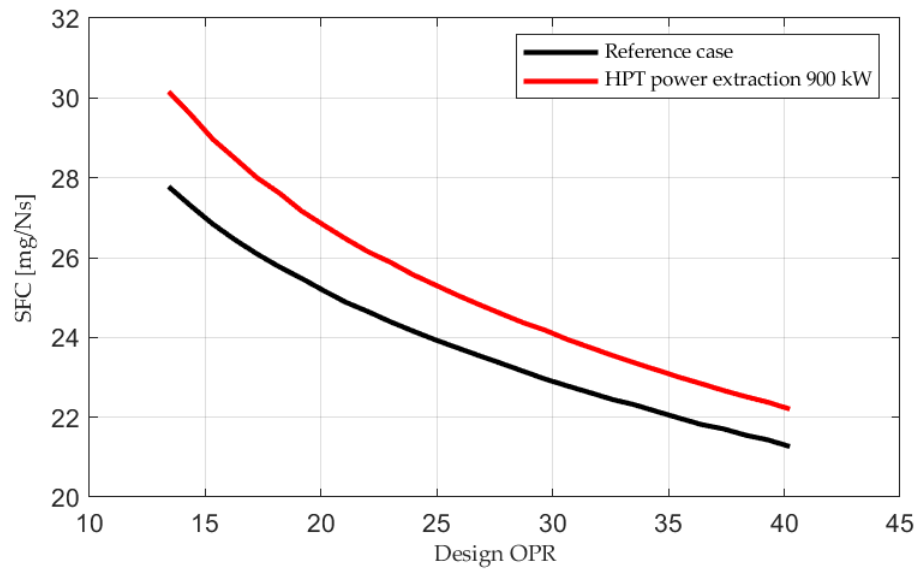
Figure 13. Point 1 of the mission. SFC plotted versus design point OPR.